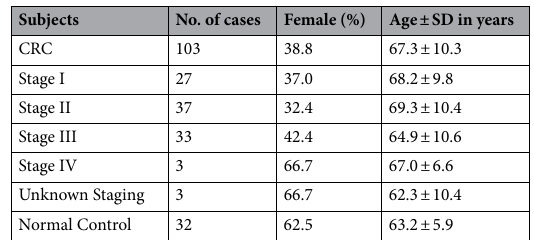
Table 1. Basic characteristics of patients and control subjects for SEPT9 detection by ddPCR. SEPT9 septin 9, ddPCR droplet digital polymerase chain reaction, SD standard deviation, CRC colorectal